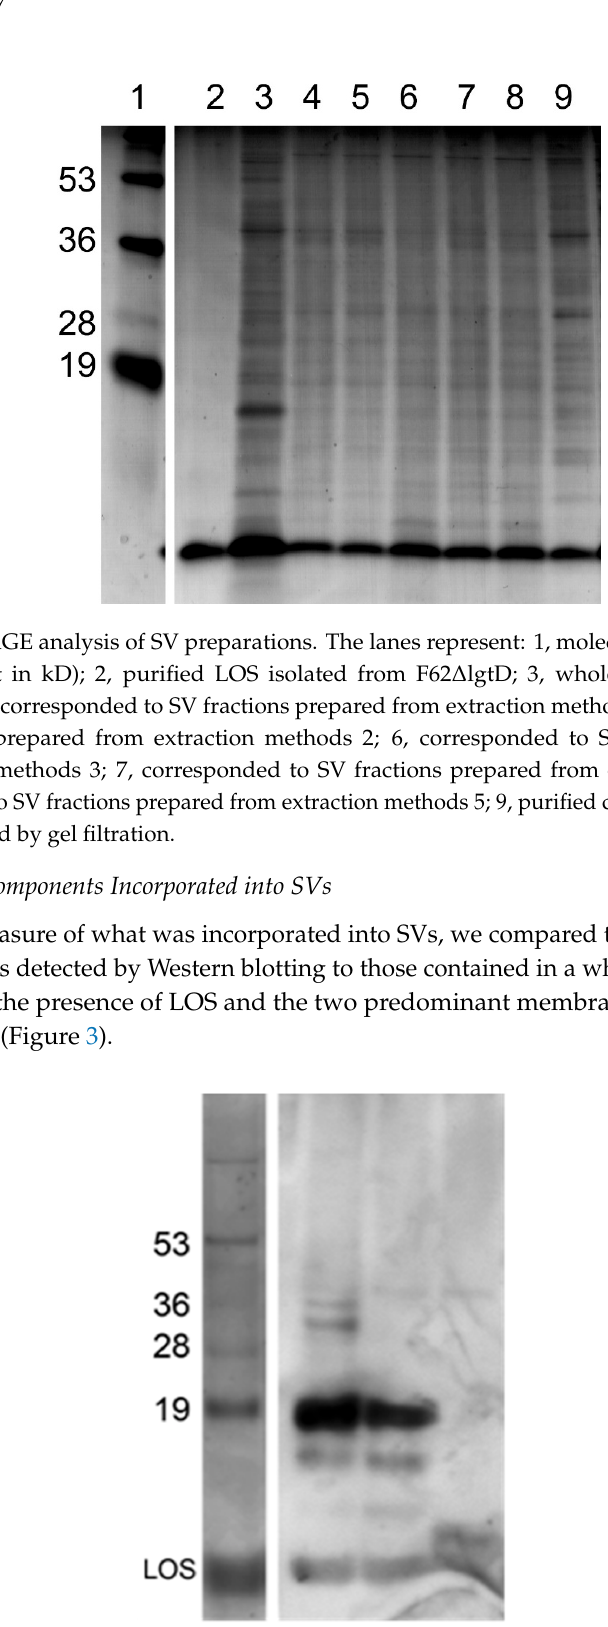
Figure 1. Gel filtration of SV extracts and whole cell lysates. Panel ( A ) represents the elution profile (1 mL fractions, 10 mL Sephadex 100 column) of SVs, and Panel ( B ) represents the elution profile (1 mL fractions, 10 mL Sephadex 100 column) of a whole cell lysate. Lanes were loaded with 1 µL of sample and analyzed by SDS–PAGE on 16.5% Tris–Tricine gels, followed by silver staining. Lanes 1 and 2 represent the void volume. MW represents the approximate location of various molecular weight marker bands. In order to demonstrate that only a subset of the cellular components of the bacteria were incorporated into the vesicles, the SVs extraction samples were subjected to electrophoresis then compared to the whole cell lysate and original cell pellet of N. gonorrhoeae ; the results of the analysis